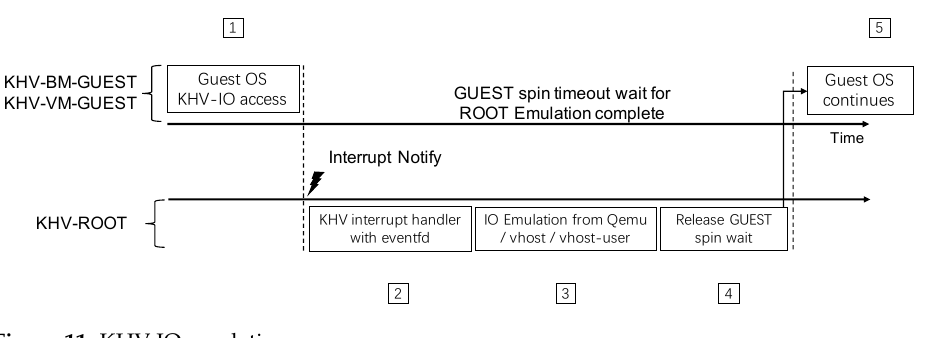
Figure 11. KHV IO emulation process.